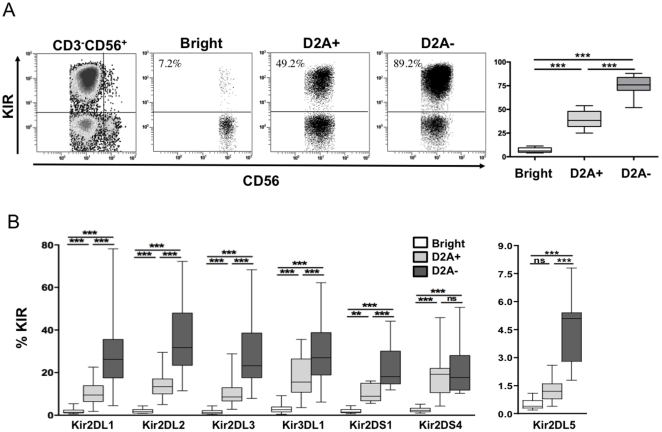
Extensive analysis of KIR expression.Cell surface expression of whole KIRs (A), or single KIR (B) on CD56bright (open bars), CD56dimNKG2A+ (grey bars) and CD56dimNKG2A− (black bars) NK cells subsets from 32 healthy controls. *: p<0,05; **: p<0.01; ***: p<0.001.